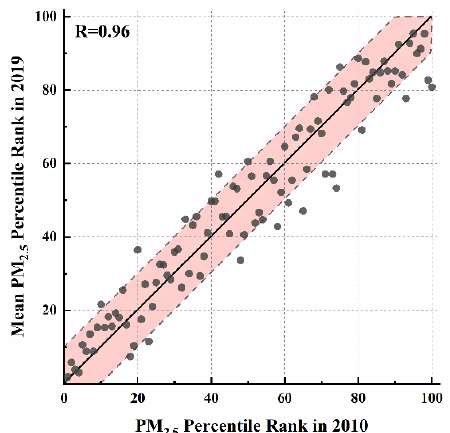
Figure 5 Rank-rank relationship between PM 2.5 percentile rank in 2010 and in 2019